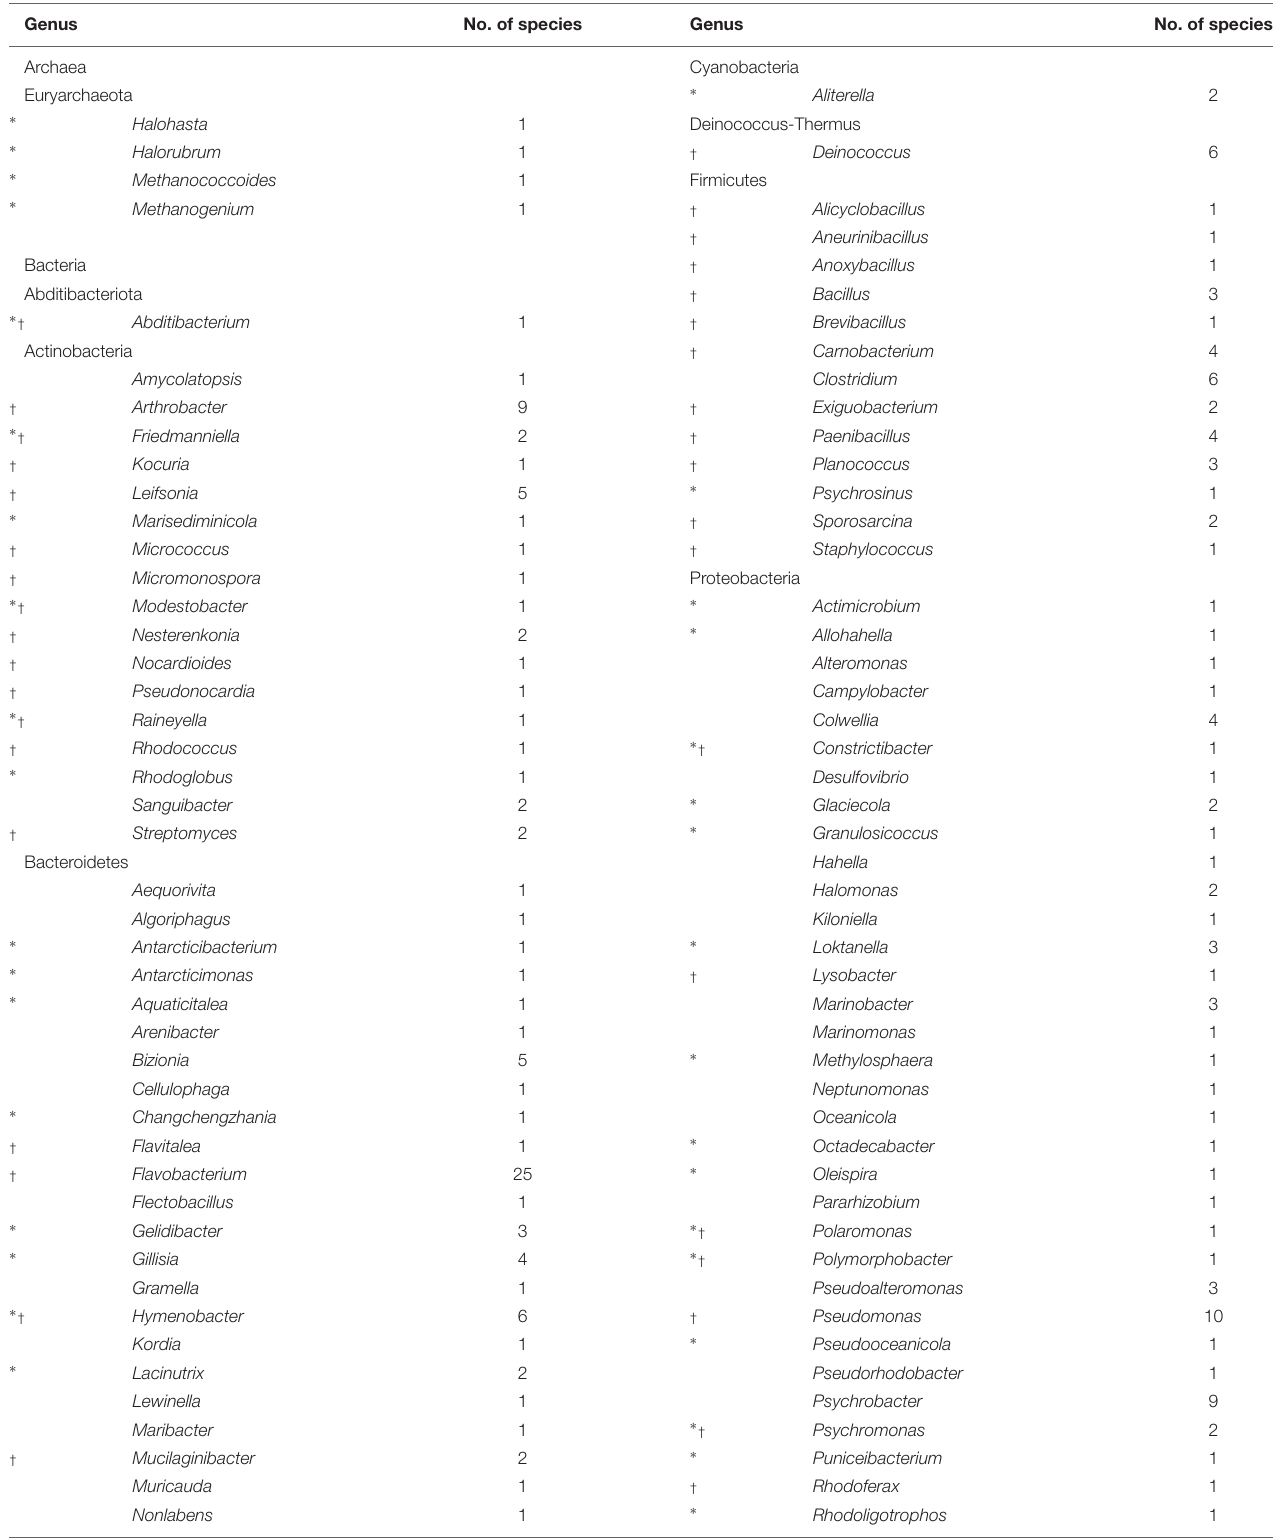
TABLE 1 | List of prokaryotic genera that contain validly described species originating from Antarctica.